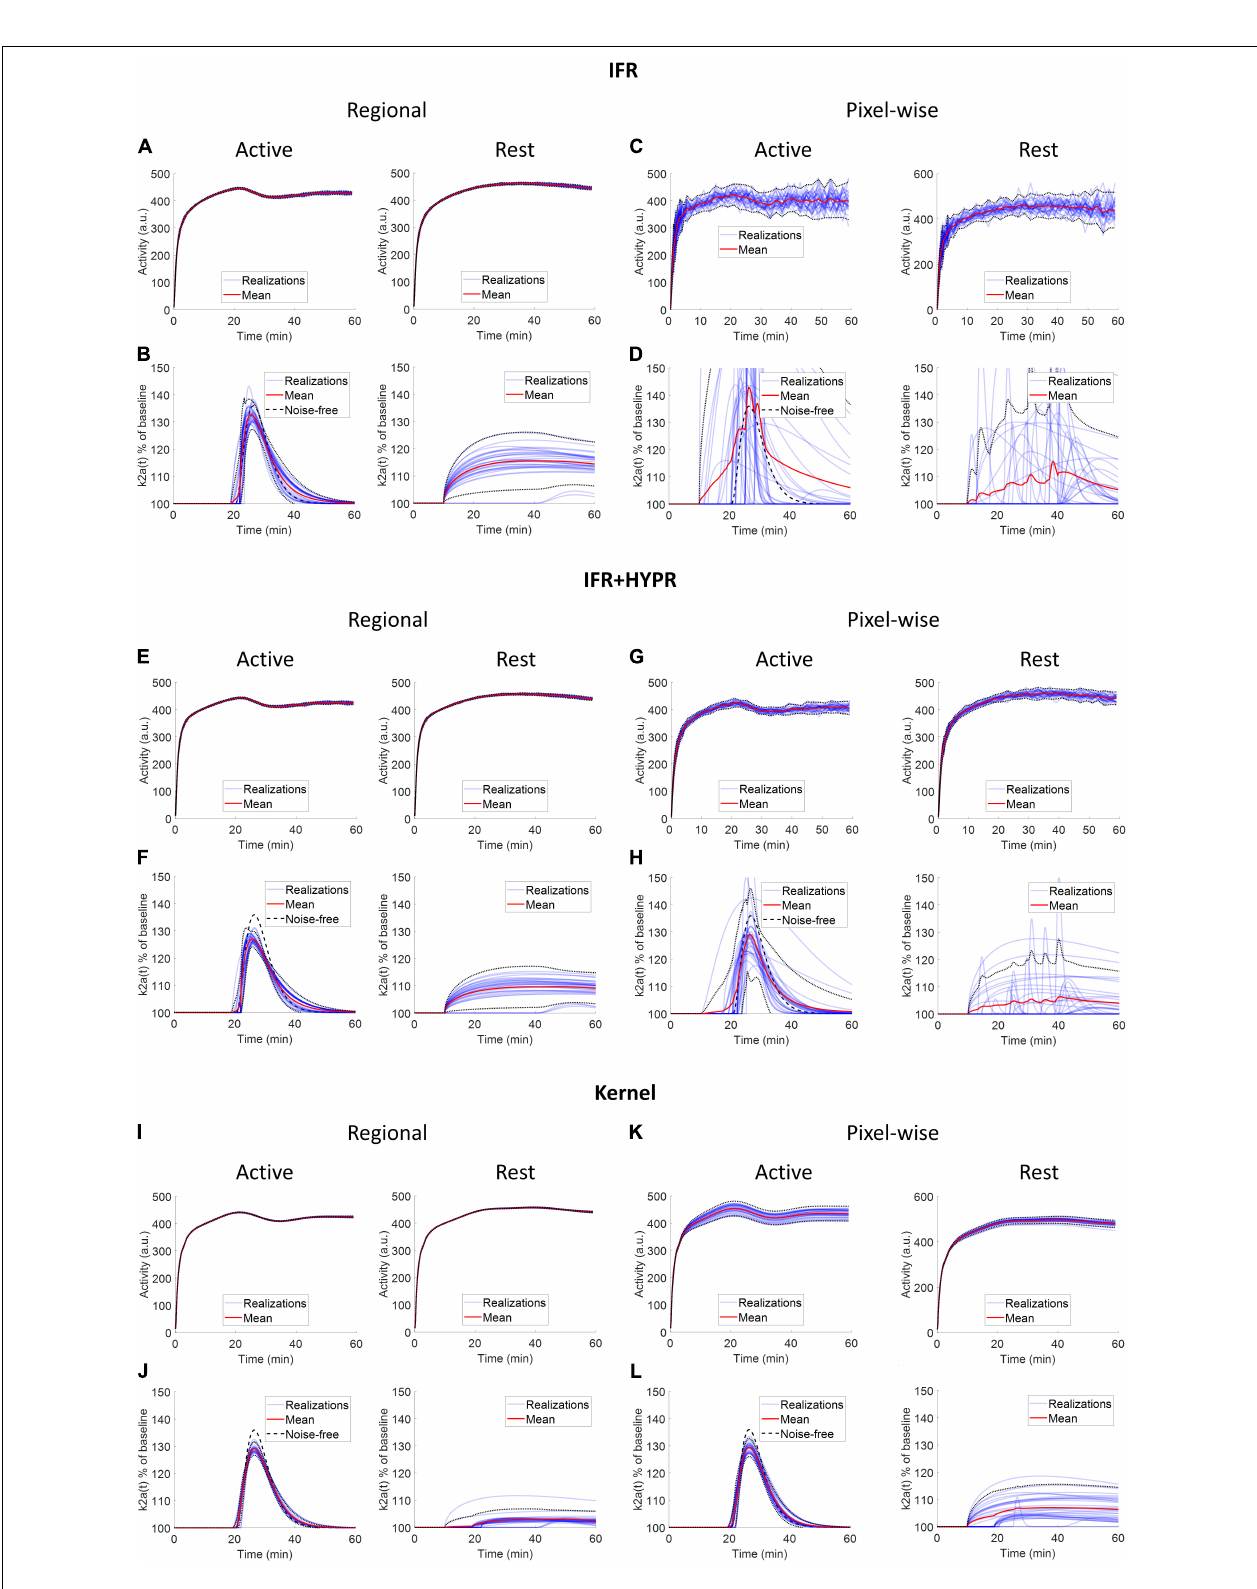
FIGURE 4 | Individual and mean TACs for every realization, at the regional (A,B,E,F,I,J) and pixel level (C,D,G,H,K,L) , and activation response profiles (ARP) for the active and rest regions, using independent frame reconstruction (IFR), independent frame reconstruction with HYPR denoising (IFR+HYPR), and spatiotemporal kernel reconstruction (Kernel), for simulations with 80 million counts. Dotted lines show 2